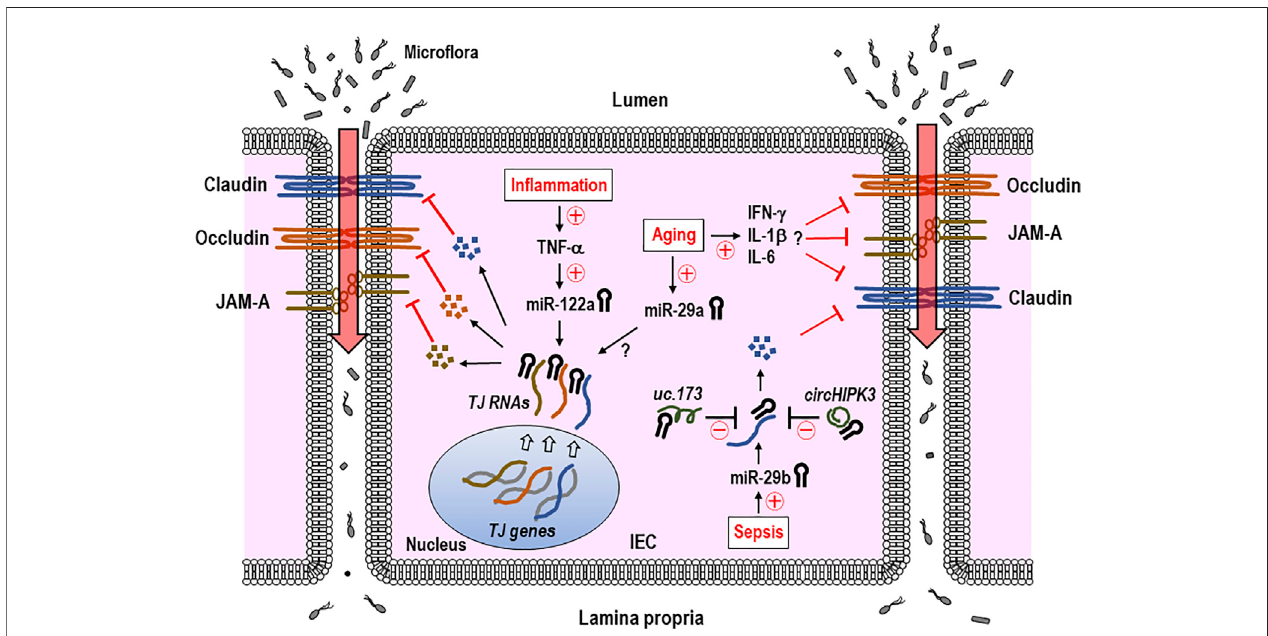
FIGURE3| IECmiRNAsregulatetheexpression oftightjunction(TJ)proteins andintestinalpermeabilityinin fl ammation,aging,orsepsis.TNF- α -induced increase inIECmiR-122aduringgutin fl ammationsuppressesthegeneexpressionofTJproteinsincludingoccludinandraisesintestinalpermeability.Aging-associatedelevation ofmiR-29aandproin fl ammatorycytokines,suchasIFN- γ ,IL-6,andIL-1 β isthoughttodownregulateTJexpressions,althoughitremainsunknownthatmiR-29adirectly binds to 3 ′ -UTR of TJ RNA. Some of the non-coding RNAs (ncRNAs), including uc.173 and circHIPK3 , were shown to interfere with miR-29b ′ s function in regulating the TJ expression of claudin-1 by binding to the sites within this miRNA speci fi c for those lncRNAs. Therefore, some of epigenetic gene regulators including miRNAs and ncRNAs appear to engage in regulating and recovering TJ expressions, respectively, and subsequent intestinal epithelial barrier. The miRNA-led reduction of the TJ proteins induces an increase in the intestinal permeability and in fl ux of micro fl ora and their products, which may eventually cause intestinal in fl ammation. Claudin,occludin,andJAM-AindicaterepresentativeTJproteins.Circled+,increase;circled − ,decrease;TJ,tightjunction;JAM-A,junctionaladhesionmoleculeA;IEC, intestinal epithelial cell; IFN- γ , interferon γ ; IL-1 β , interleukin 1 β ; circHIPK3, circular homeodomain-interacting protein kinase 3.